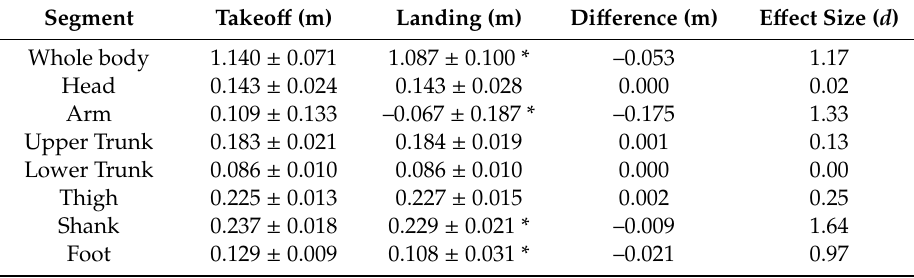
Table 1. The vertical component of the segment center of mass (COM k ) at takeo ff and landing.